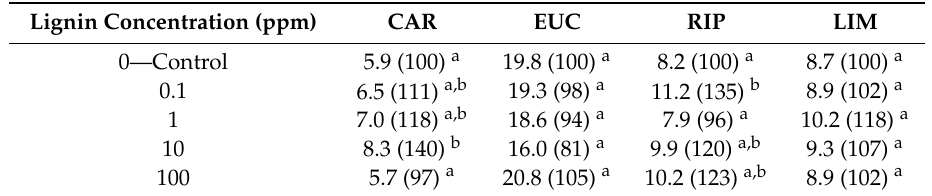
Table 4. Length (cm) of lateral seminal roots for maize seedlings treated with different concentrations (ppm) of CAR, EUC, RIP and LIM water-soluble lignins. Lignin Concentration (ppm) CAR EUC